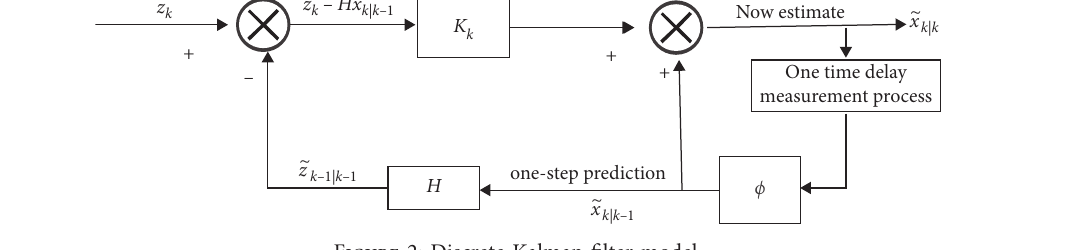
Figure 2: Discrete Kalman filter model.